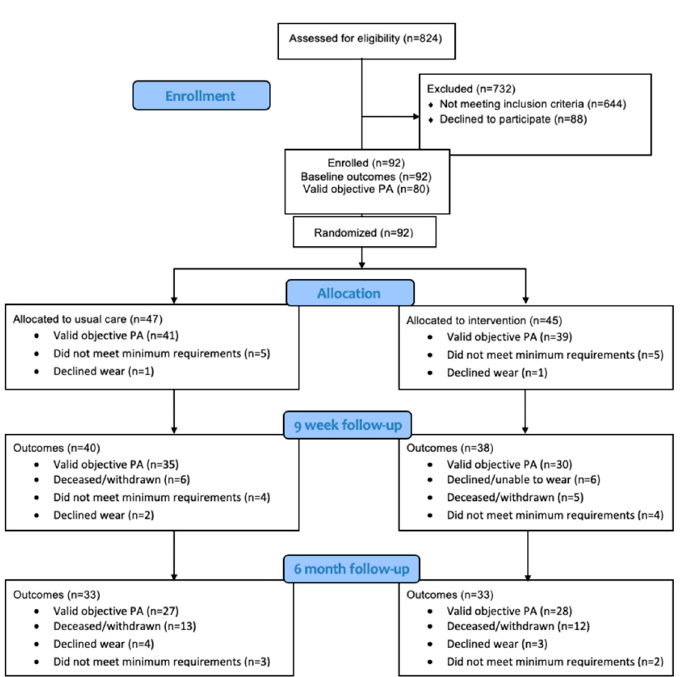
Figure 1. Flow of participants through the trial with valid objective physical activity (PA) measures.